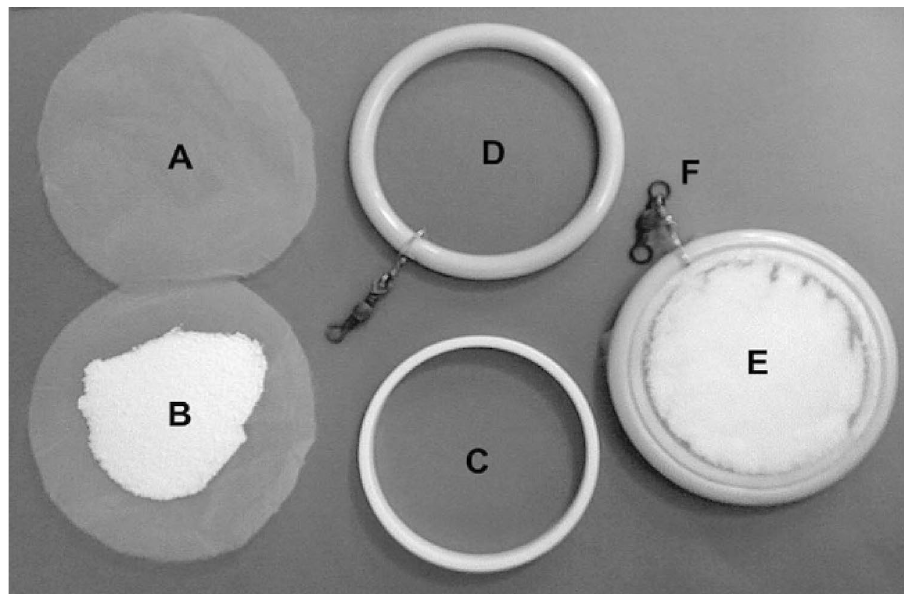
Fig. 2 Fully assembled pas- sive sampling disk E , and its parts: A 100 μm nylon mesh; B Diaion® HP-20 resin; C inner and D outer rings of a 75 mm diameter embroidery ring with F a No. 2 fishing swivel attached (adapted from